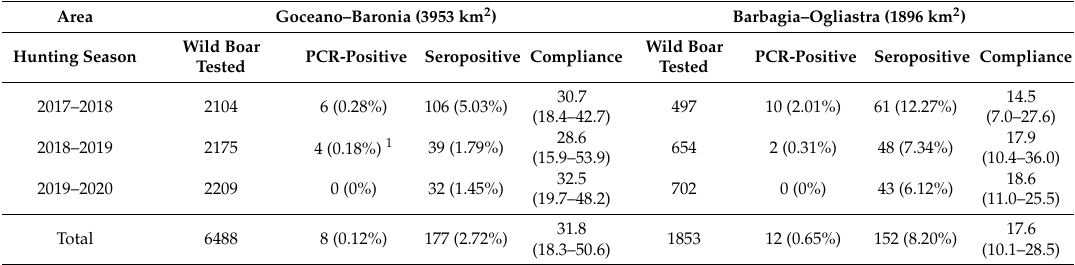
Table 1. Descriptive analyses of the Goceano–Baronia and Barbagia–Ogliastra areas on the data included in the models. Data are presented as the frequency (prevalence expressed as %) and median (interquartile